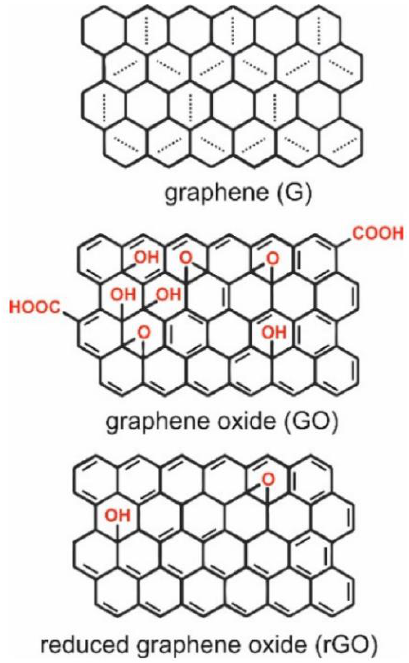
Figure 1. Structures of graphene (G), graphene oxide (GO), and reduced graphene oxide (rGO) (Reused with permission from Nanomaterials, MDPI [16]). Aromaticity in graphene is local, with two π -electrons located over every hexagon ring [17].